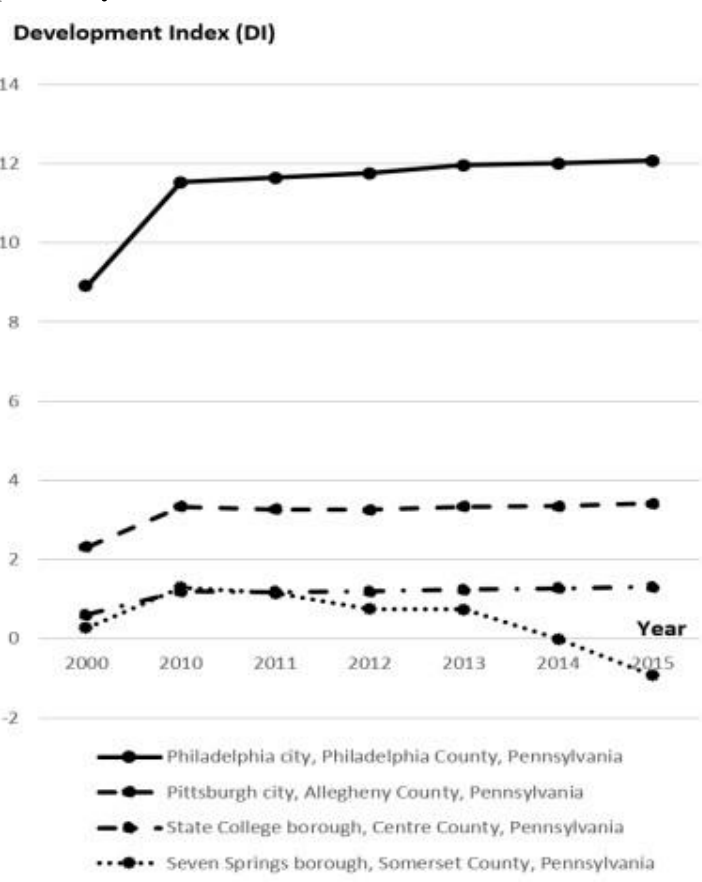
Figure 4 Index change for 4 towns and